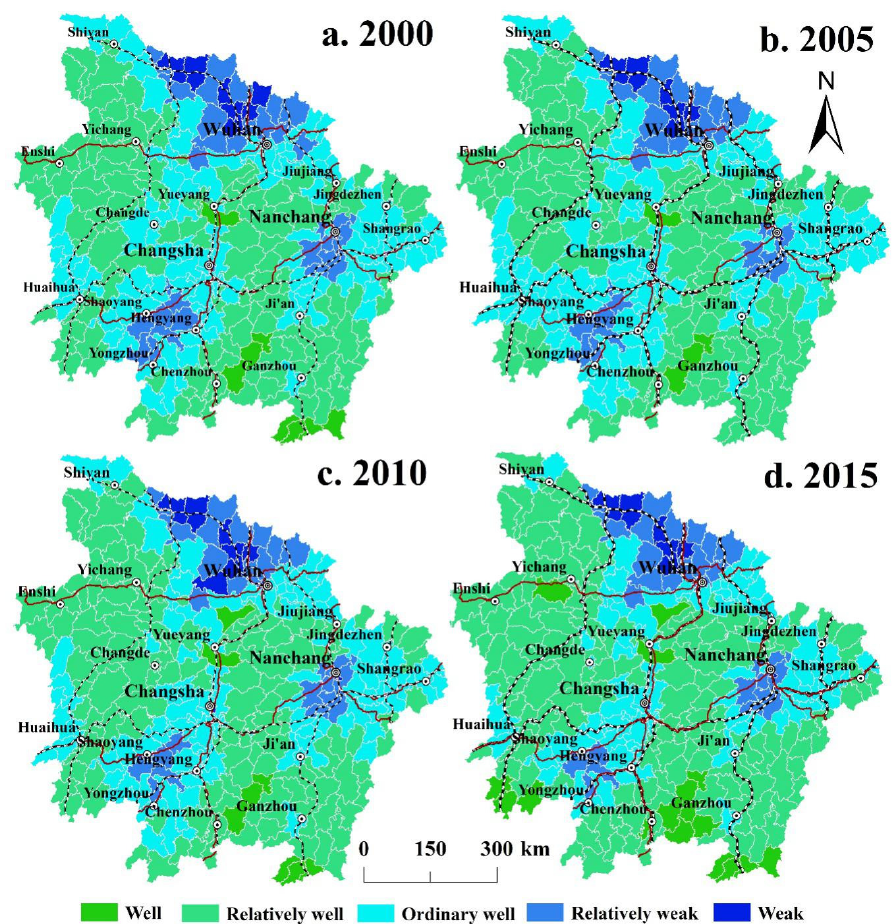
Figure 2. Ecosystem health levels in the MRYRUA from 2000 to 2015.